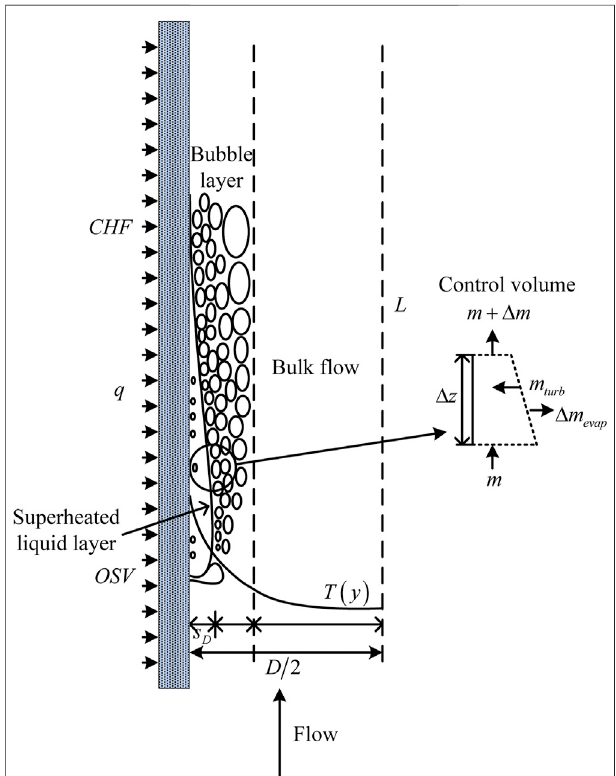
FIGURE 3 | Schematic diagram of the DNB